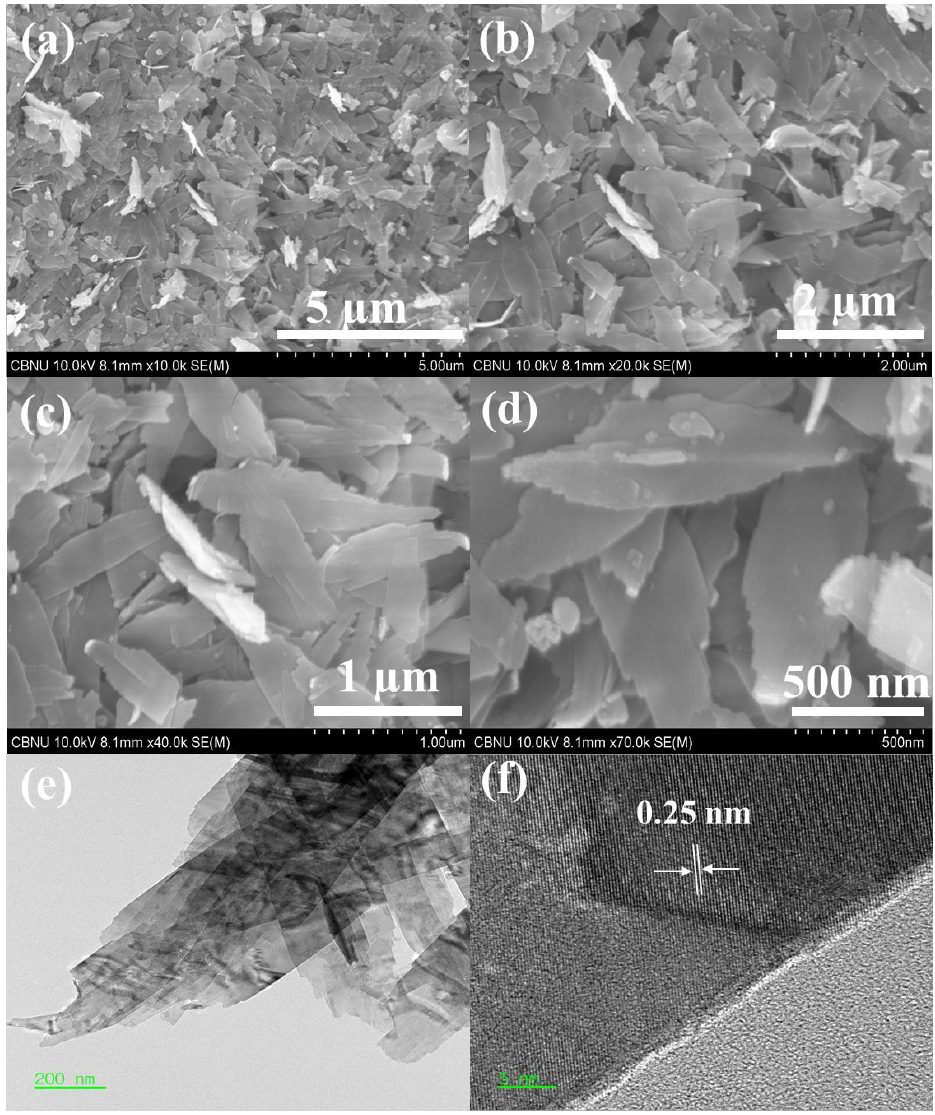
Figure 2. ( a , b ) Low-magnification, ( c , d ) high-resolution FESEM images, ( e ) TEM image and ( f ) high-resolution TEM image of hydrothermally synthesized leaf-shaped CuO nanosheets.